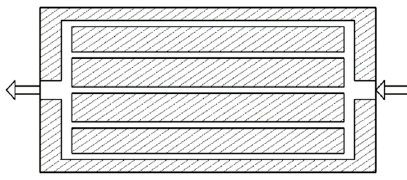
Figure 6. Initial design of cooling plate.